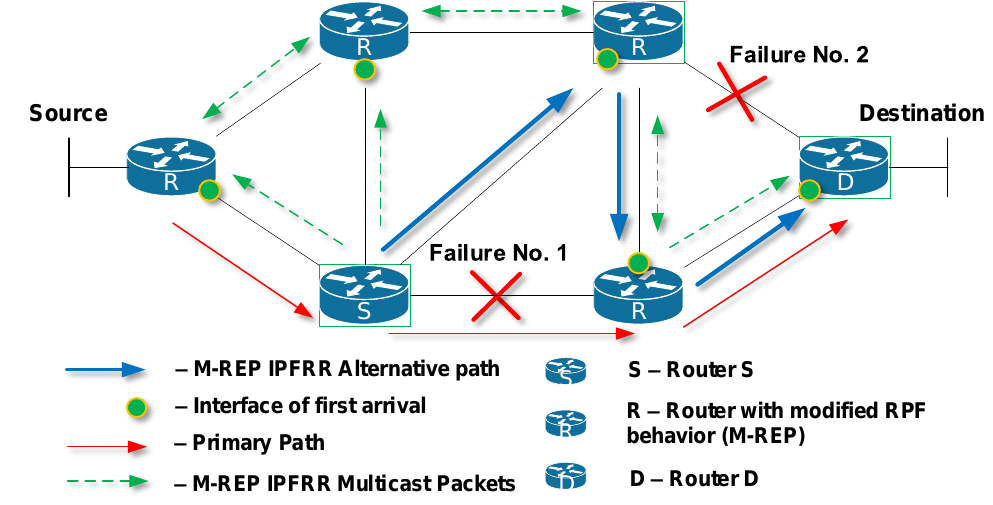
Figure 7. M-REP: reroute in the event of multiple failures.